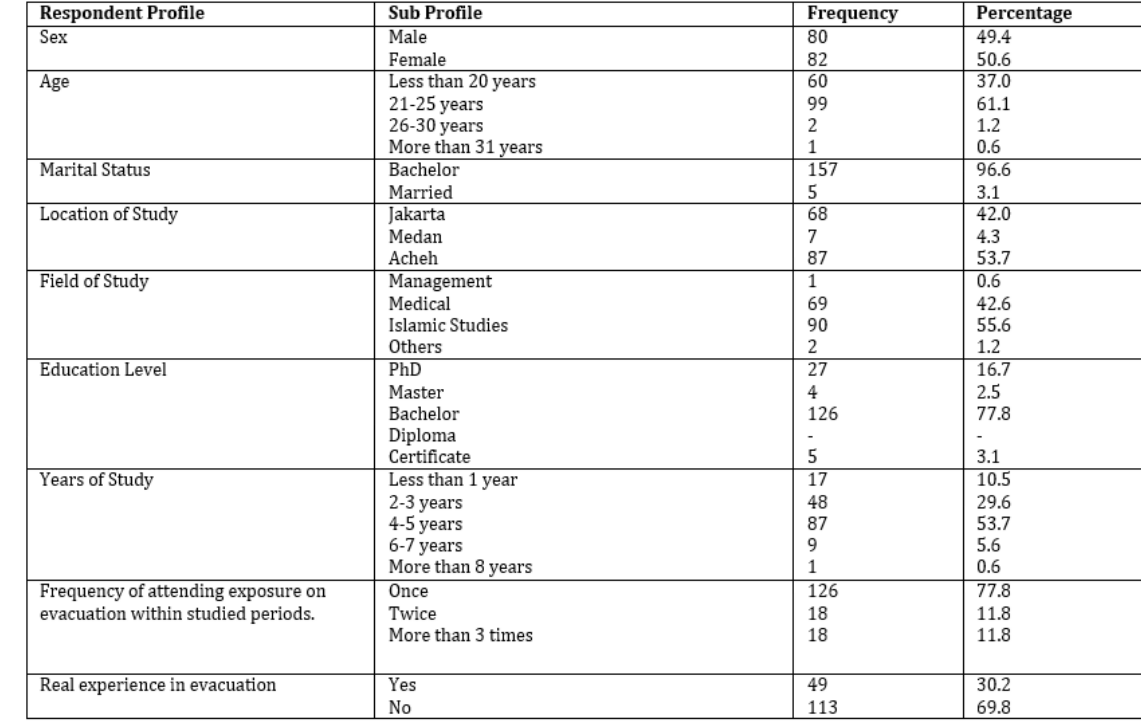
hows the factor loadings and cross loadings for different constructs. The correlation between items and factors had higher loadings than